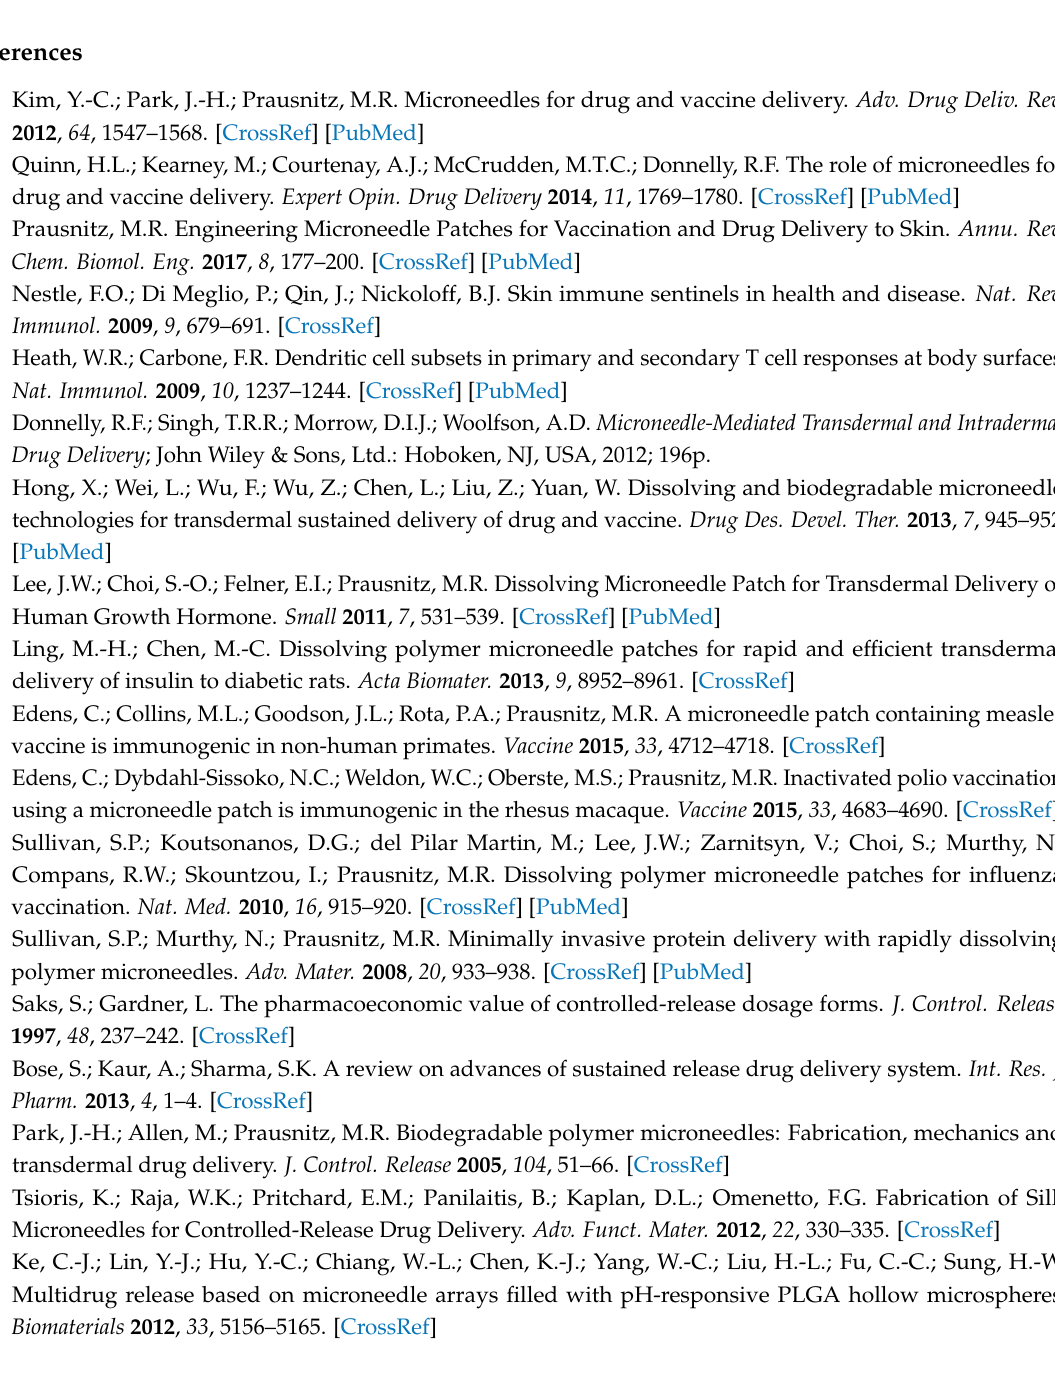
Figure S1: (A) CD spectra of native, degraded BSA, and BSA in PLGA and PVP layer. (B) Fluorescence spectra of native, degraded BSA, and BSA in PLGA and PVP